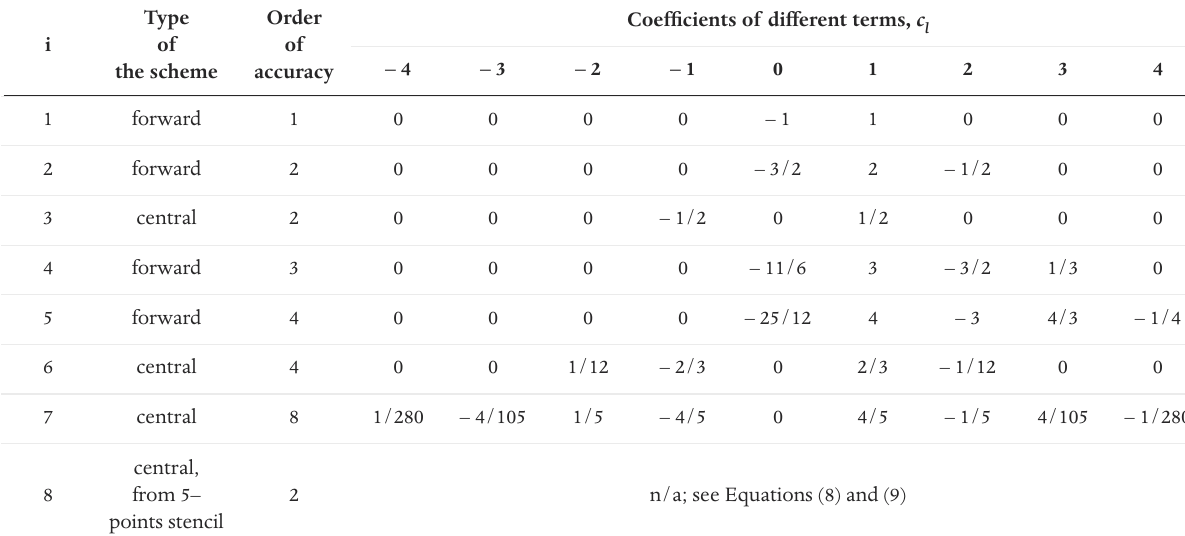
} of Equations (6) and (7) are also l and l of Equation (6), start end